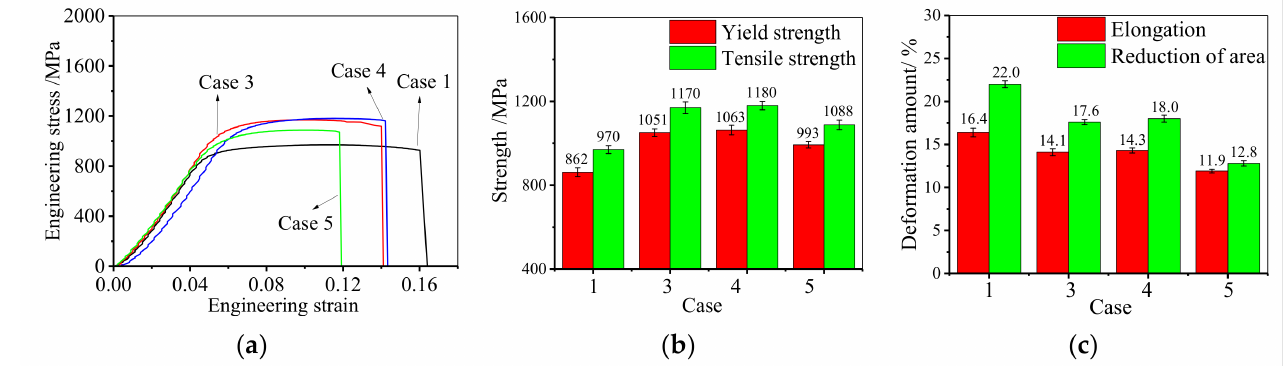
Figure 3. Effect of FSA time on tensile mechanical properties: ( a ) engineering stress–engineering strain curve; ( b ) strength; ( c ) elongation to